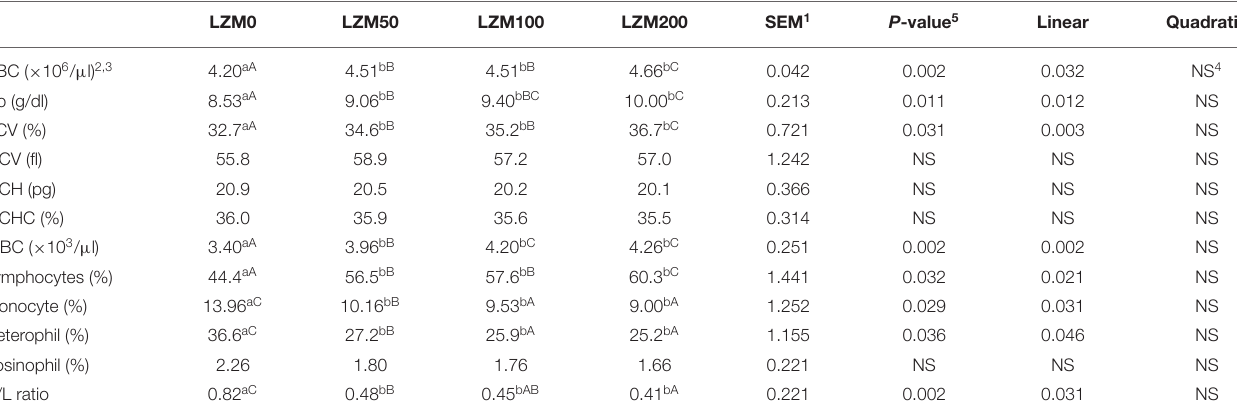
TABLE 4 | Effect of varying levels of chicken egg lysozyme (LZM) on hematological variables of growing